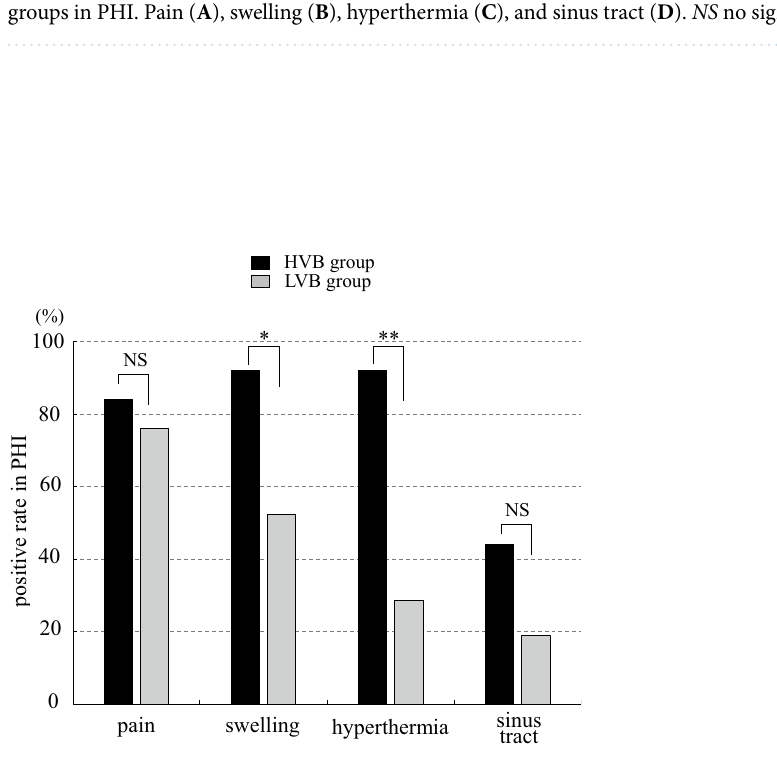
Figure 4. Frequency of local findings according to virulence of causative bacteria in periprosthetic hip infection (PHI). The positive rates of swelling and hyperthermia were significantly lower in low-virulent bacteria (LVB) group than high-virulent bacteria (HVB) group. **p < 0.01, *p < 0.05, NS no significant